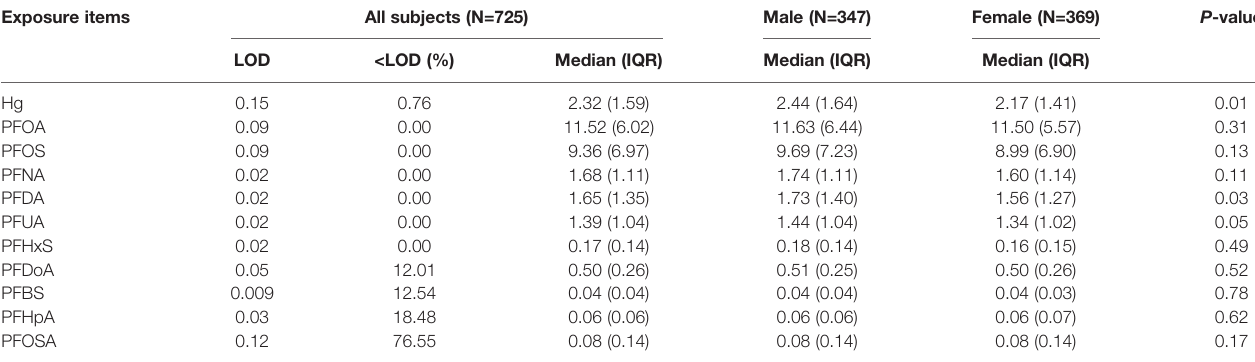
TABLE 2 | Per fl uoroalkyl substances (PFAS, ng/mL) exposure level during early pregnancy, strati fi ed by child sex. Exposure items